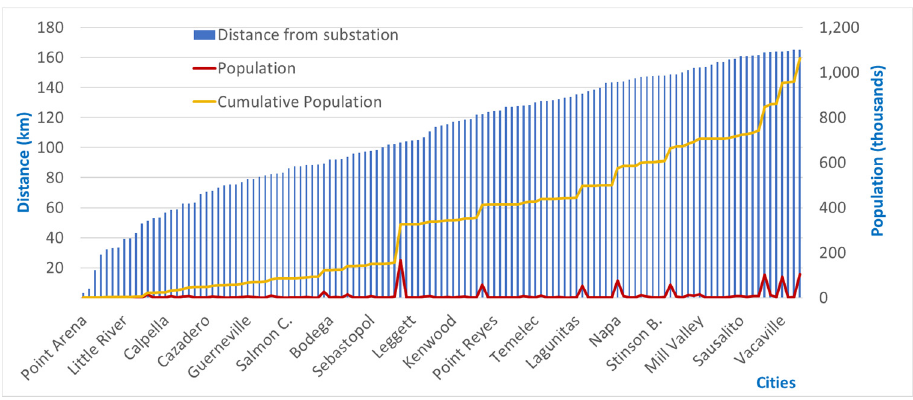
Figure 15. Analysis of distance from onshore substation and population for proposed offshore wind turbines in Point Arena, Northern California.